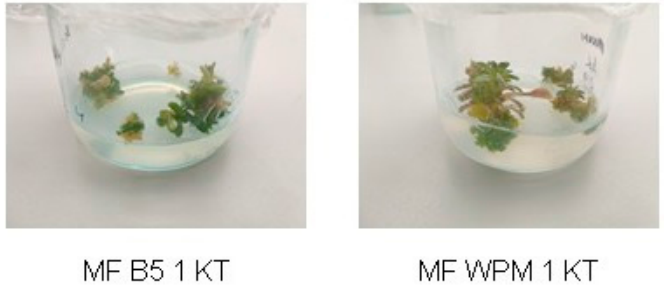
Figure 4. The effect of different media with m T on plants of H. cretaceus shoots in vitro .